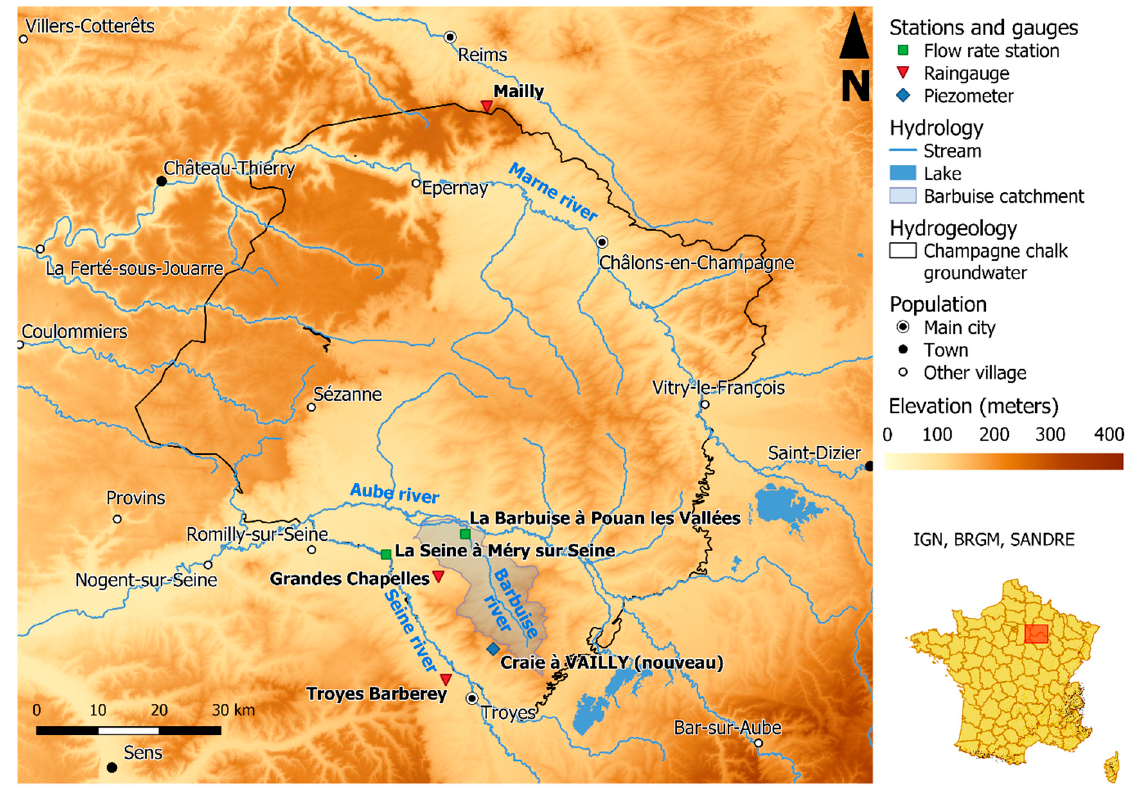
Figure 2. Map of the Champagne chalk groundwater basin (IGN, BRGM, BD Carthage).